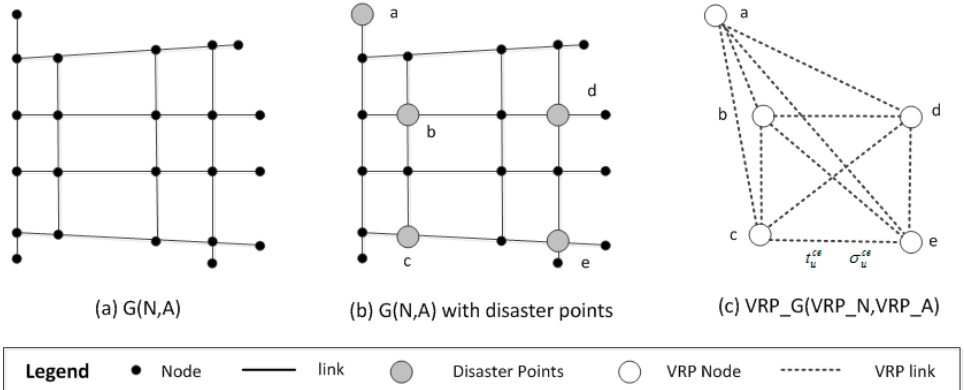
Figure 1. Example of bi-level rescue network.